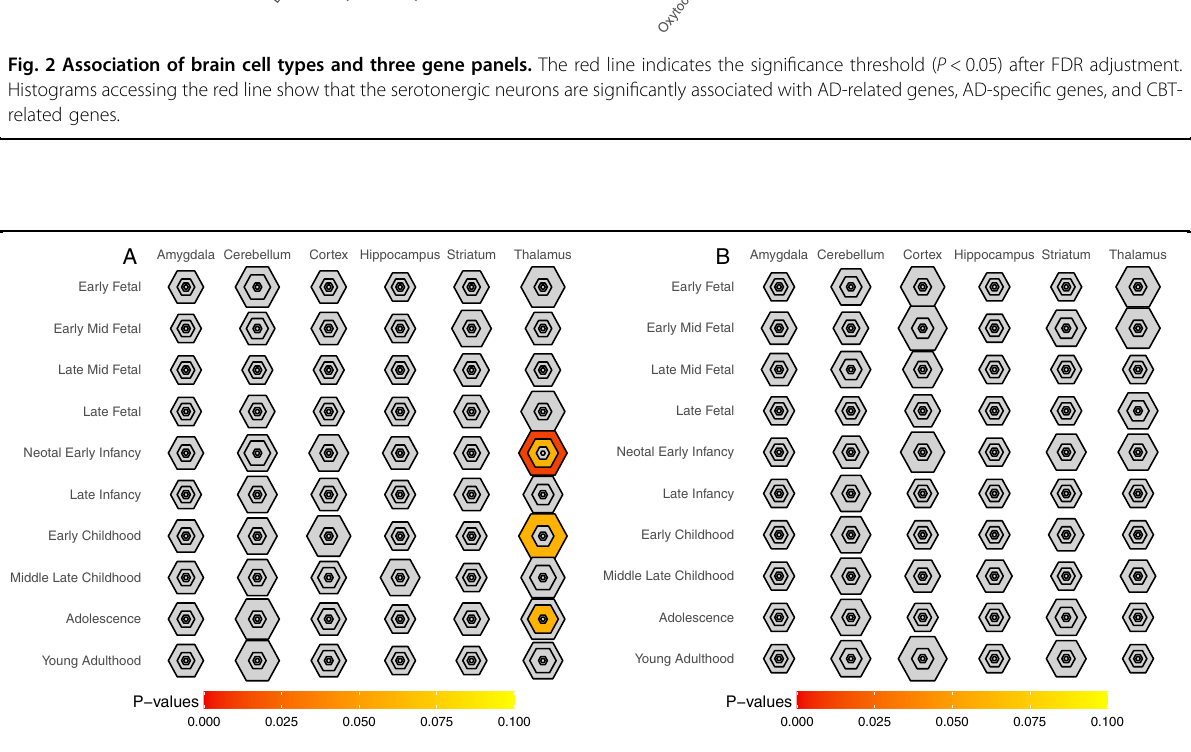
Fig. 3 Time-speci fi c expression of CBT-related genes (A) and AD-related genes (B). The size of the hexagons from outside to center correspond to the pSI thresholds (0.05, 0.01, 0.001, 0.0001), respectively. Colors indicate the FDR-adjusted P -values. The CBT-related genes show signi fi cant expression during early infancy, early childhood, and adolescence in the